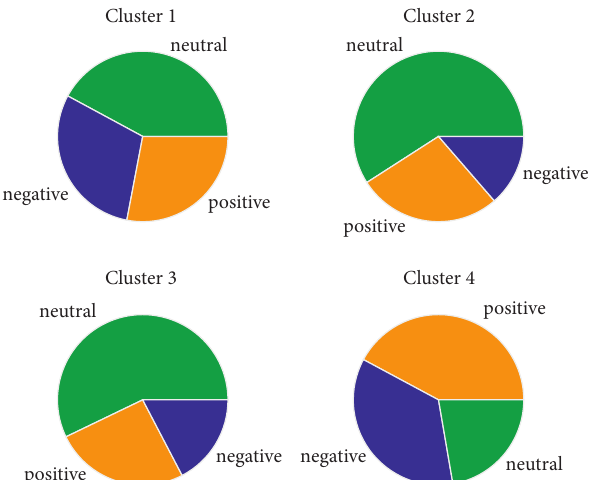
Figure 5: Polarity analysis for the four clusters of Scenario 1 using SLP